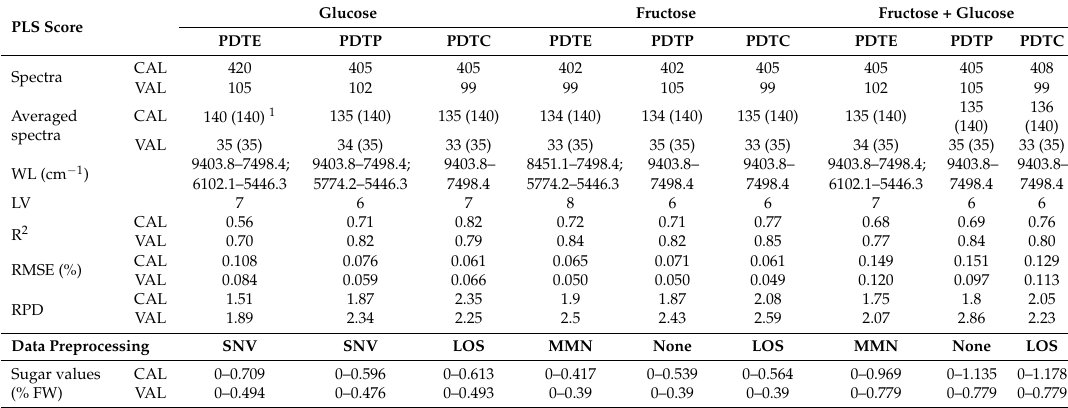
Table 3. PLS values of sugar content prediction of the potato variety Innovator.